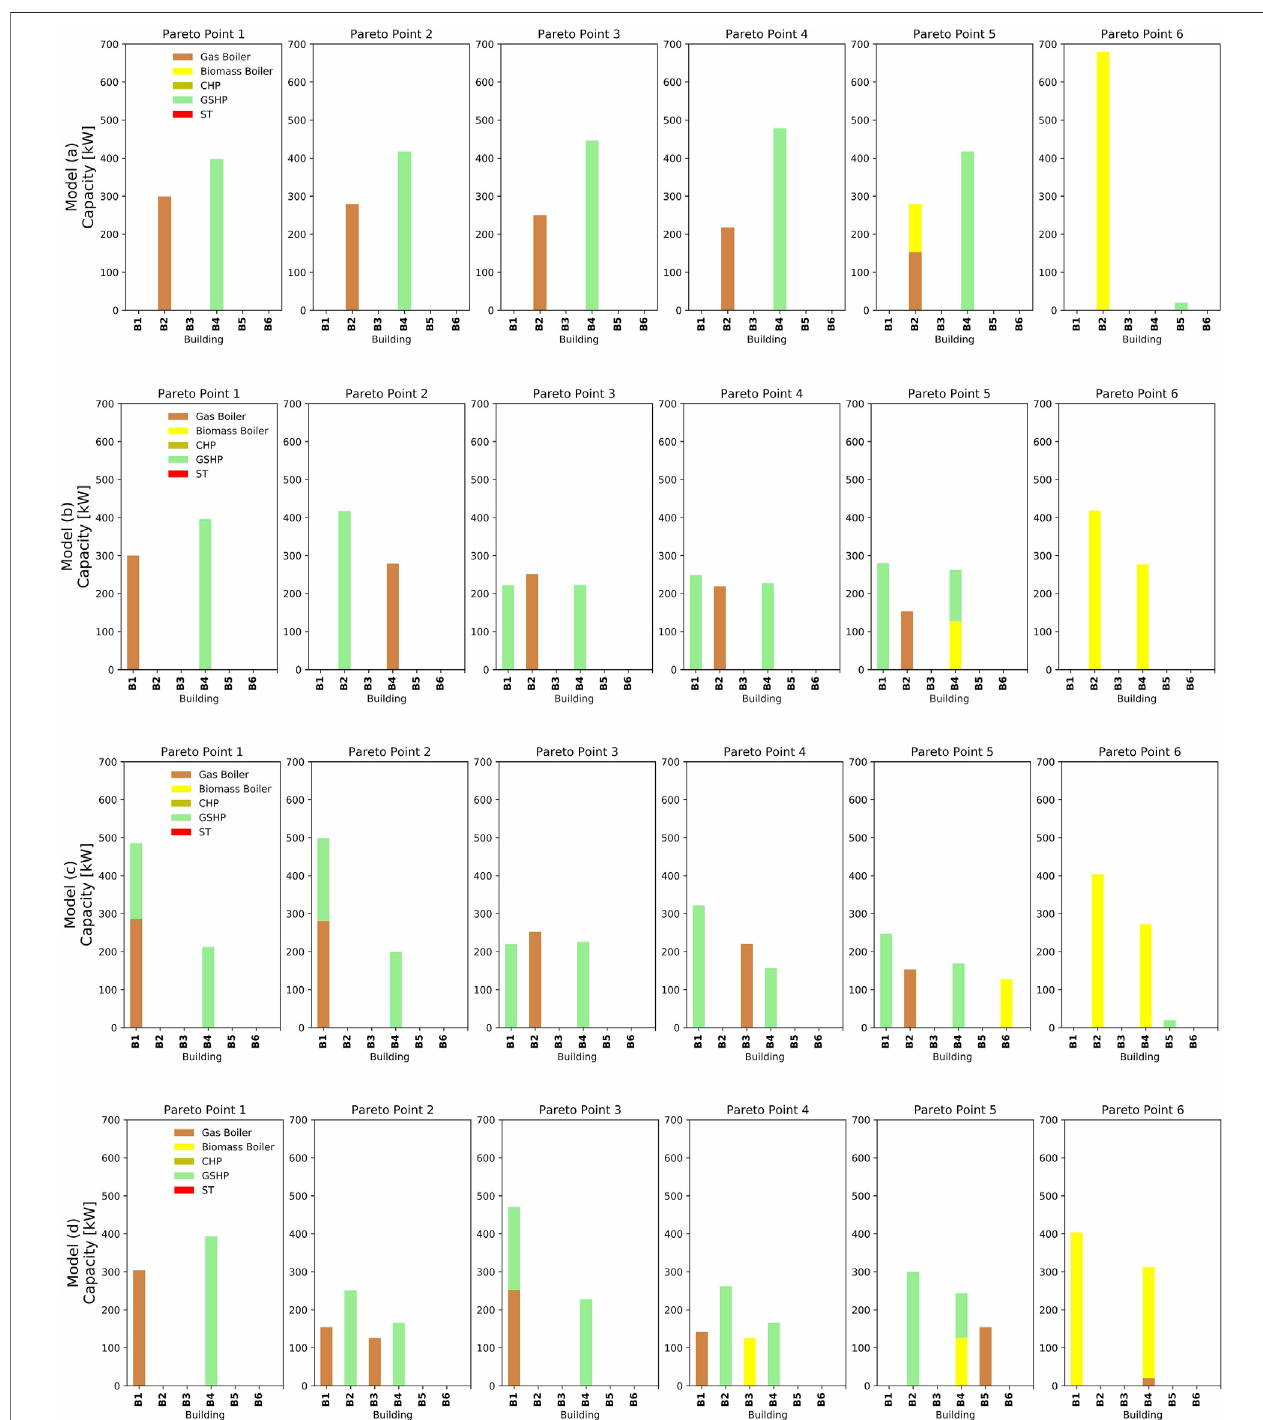
FIGURE 12 | Design capacities of heating technologies at each building from the model (A) - (D) .